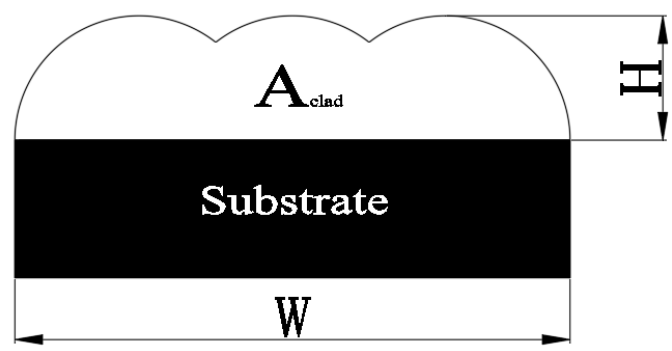
Figure 2. Schematic cross-section diagram of multi-track clad.